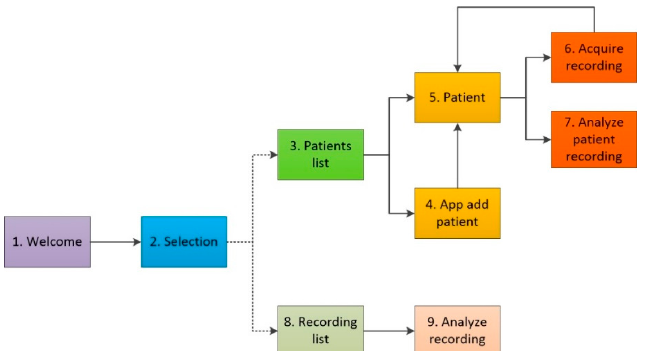
Figure 2. Mobile app flowchart for the automated detection of respiratory crackles. In the flowchart each block represents an activity that was implemented in the app.